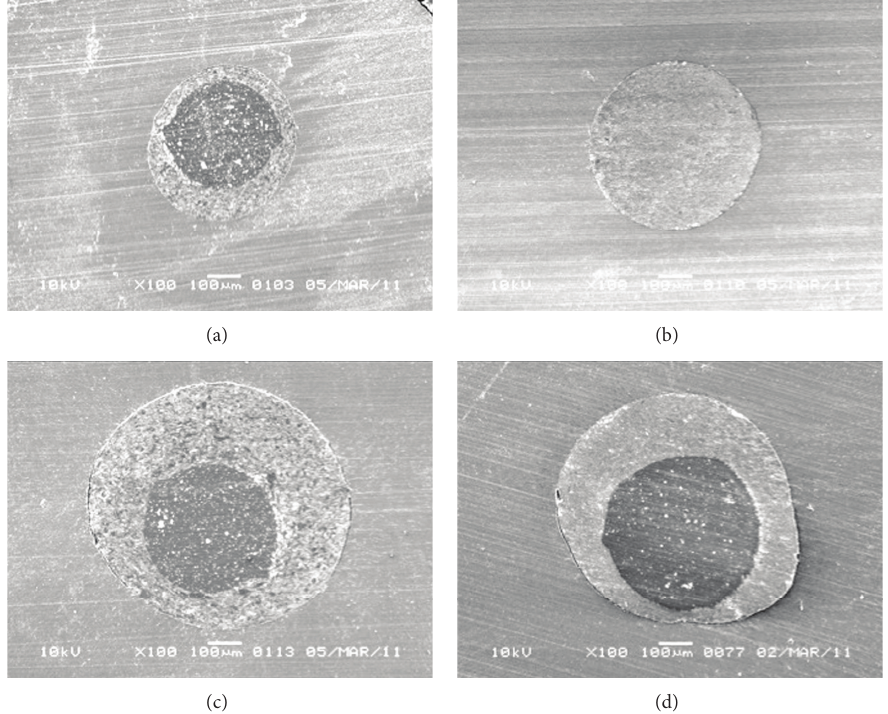
Figure 2: Scanning electron microscopic image of the cross-section of the canal at 2 and 4mm away from the apex (100x). (a) 2mm filled with RealSeal 1, (b) 2mm filled with Thermafil, (c) 4mm filled with RealSeal 1, and (d) 4mm filled with Thermafil.